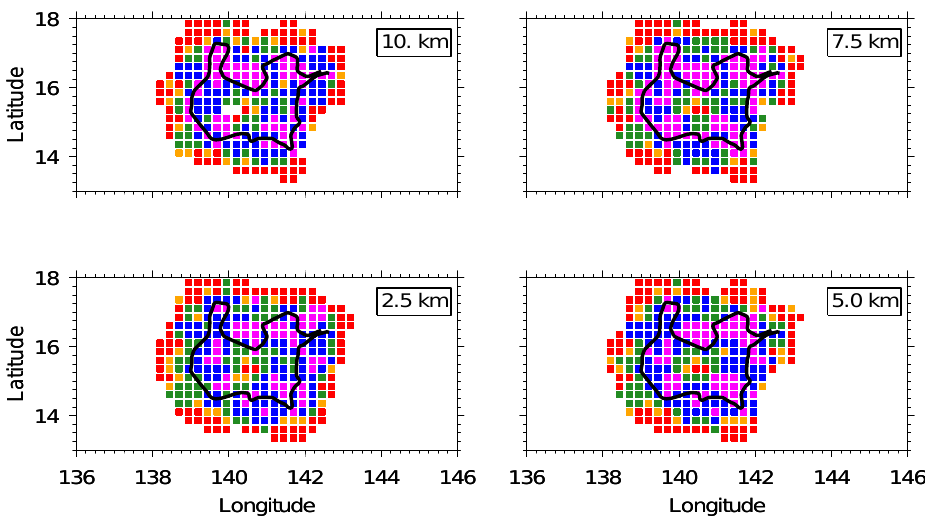
Fig. 3. This figure shows plan views of the error associated with the component of the gridded velocity along the eigen-direction with the second largest eigenvalue (see Eq. 9). The marks represent grid points that had more than 50 radar observations associated with them. Marks in red represent errors larger than five ms − 1 ; errors between five and four ms − 1 are shown in orange, between four and three ms − 1 in green, between three and two in blue, and between two and one in magenta (no points had errors smaller than 1). The thick black line represents the aircraft